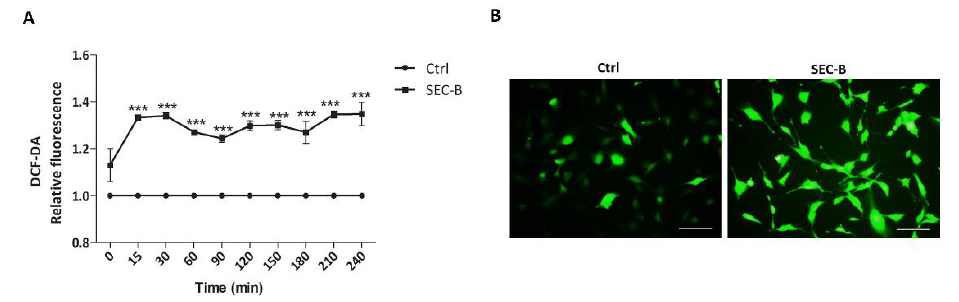
Figure 2. SEC-B induces ROS production in HMEC-1 cells. ( A ) Increased intracellular ROS levels in HMEC-1 cells within the first 4 h of SEC-B treatment. Data are expressed as a fold increase of DCF-DA fluorescence emission compared to control conditions. The mean ± SD ( n = 3) is indicated. *** p < 0.001 vs. untreated cells. ( B ) Representative microscopy images of HMEC-1 labeled with DCF-DA probe after 4 h of SEC-B treatment. The images are obtained by optical fluorescence microscopy using the 20× objective. Scale bar: 100 µm.